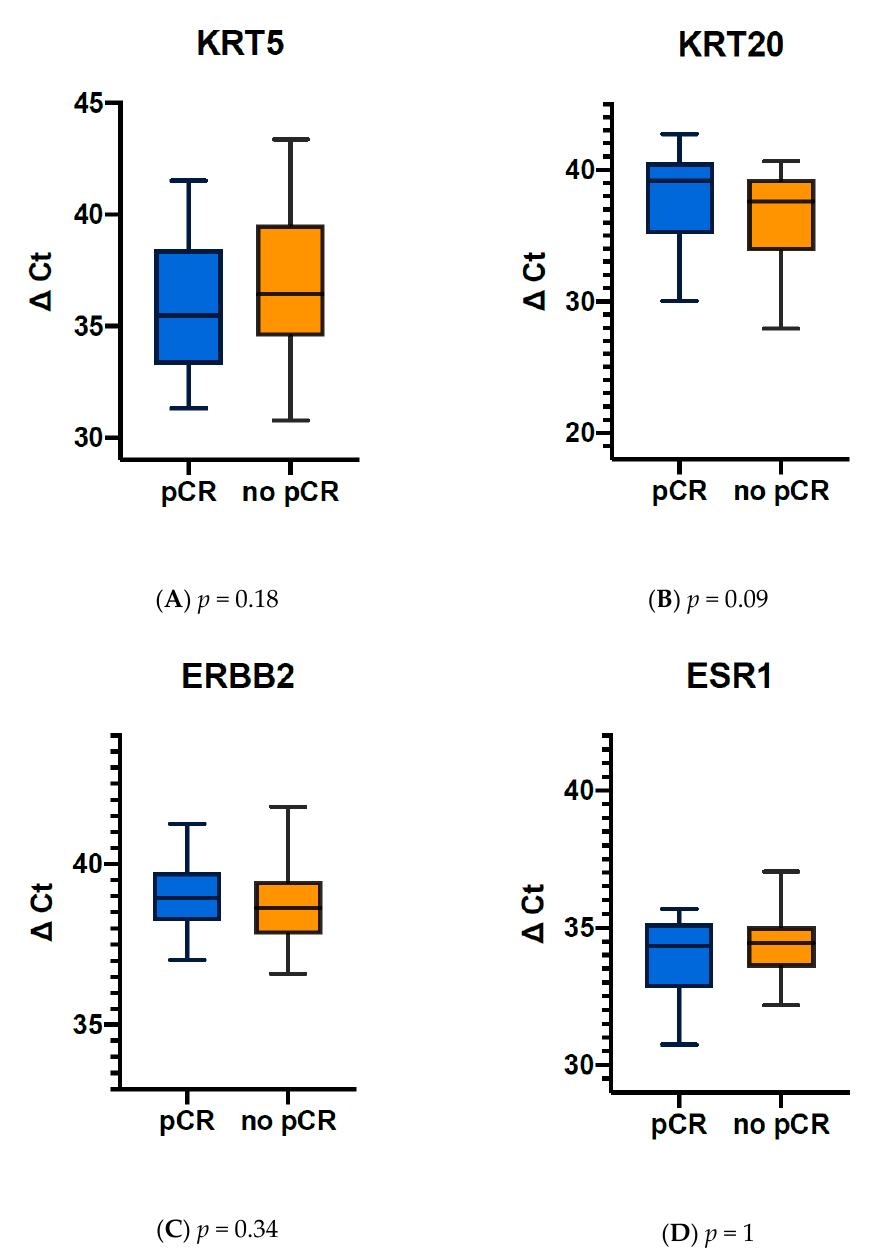
Figure 3. Cytokeratin mRNA expression ( Δ CT) in MIBC patients with and without pathological complete response (pCR). ( A ) KRT5 expression, ( B ) KRT20 expression, ( C ) ERBB2 expression, ( D ) ESR1 expression.